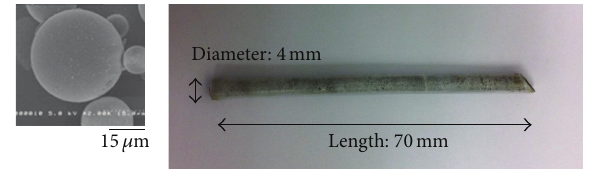
Figure1:Shapeofglassbead(left)andinsulatingconcretespecimen